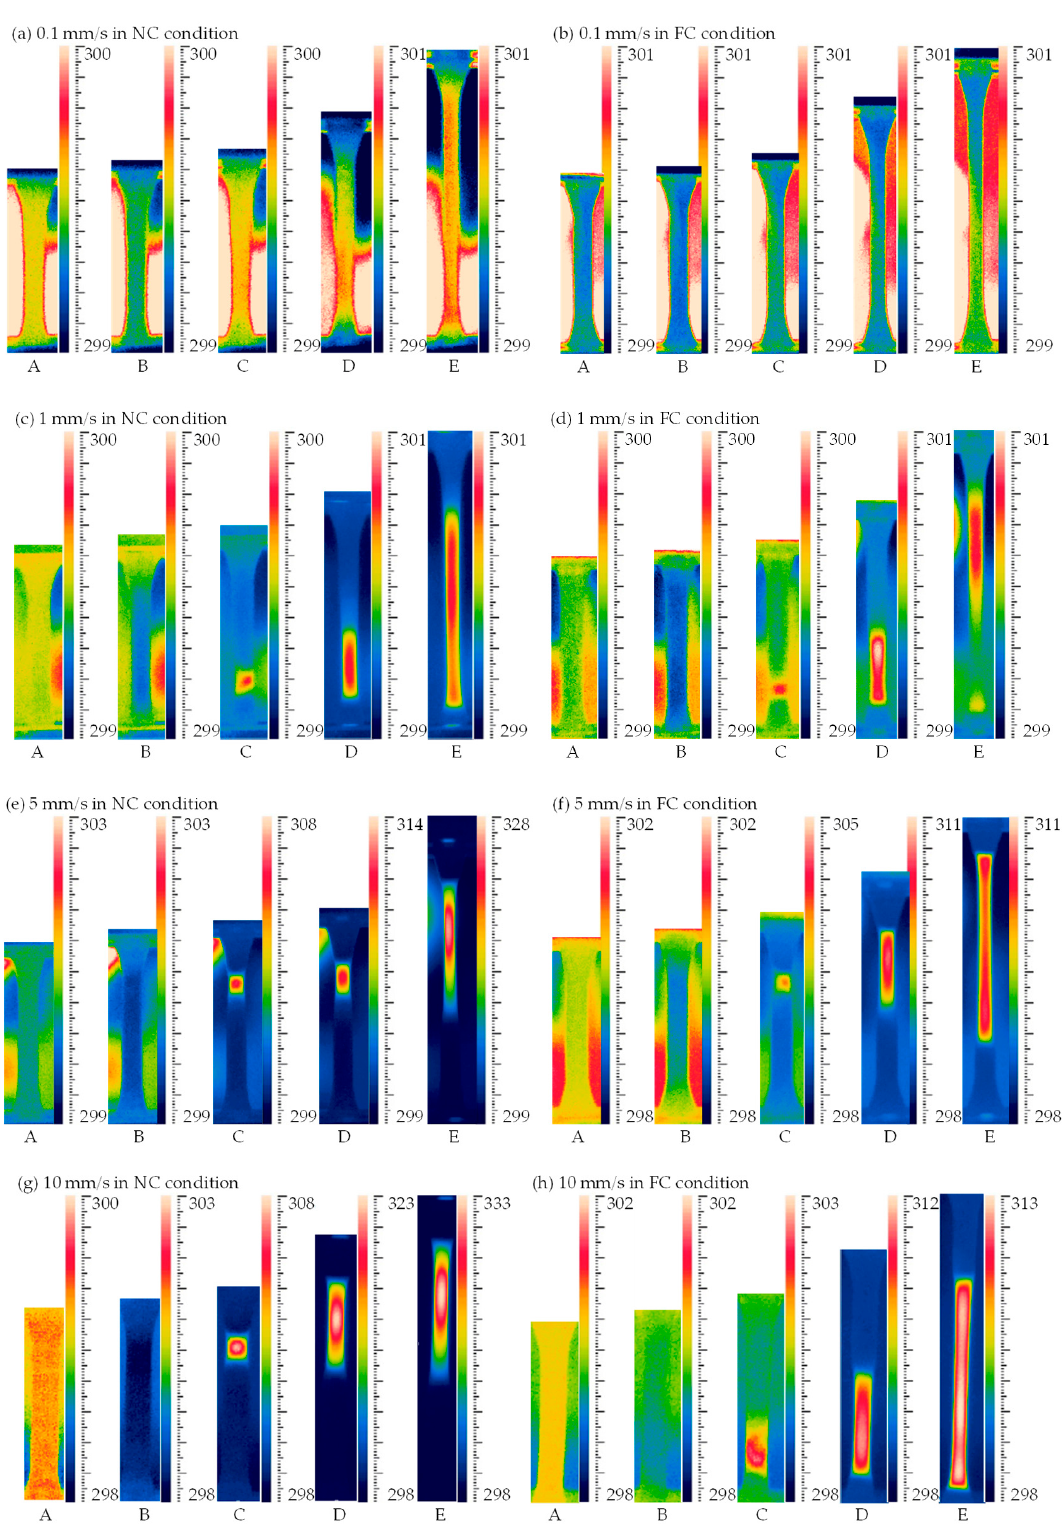
Figure 9. Temperature contours at di ff erent loading rates of ( a ) 0.1 mm / s in the NC condition; ( b ) 0.1 mm / s in the FC condition; ( c ) 1 mm / s in the NC condition; ( d ) 1 mm / s in the FC condition; ( e ) 5 mm / s in the NC condition; ( f ) 5 mm / s in the FC condition; ( g ) 10 mm / s in the NC condition and ( h ) 10 mm / s in FC condition.